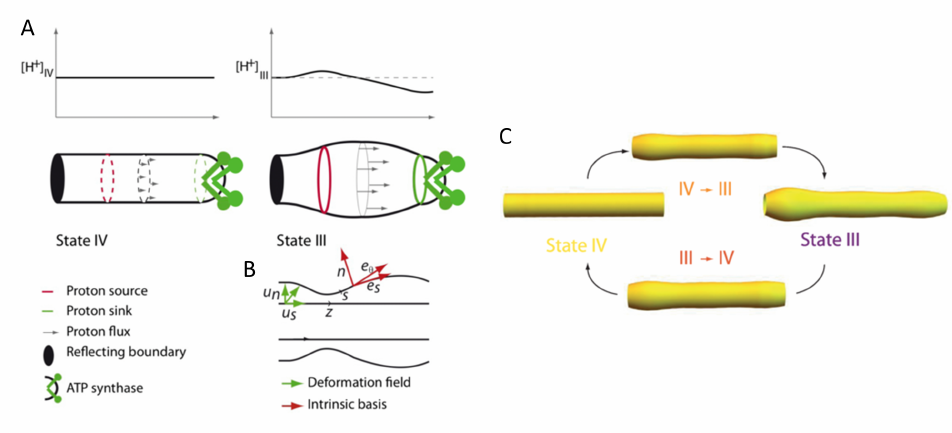
Figure 7. Mitochondrial cristae modeled as an out-of-equilibrium membrane driven by a proton field. Schematic represen- tation of a cristae: ( A ) The plots represent the proton concentration on the surface in states III and IV. The tubes represent the shape of the invagination in state III and IV; ( B ) Deformation fields of the membrane and intrinsic basis of the deformed surface. ( C ) Changes in the cylindrical shaped model cristae morphology as the mitochondrion transitions between the two mitochondrial states IV and III. Reproduced with permission from Patil et al. [94], Phys. Rev. E; published by the APS,